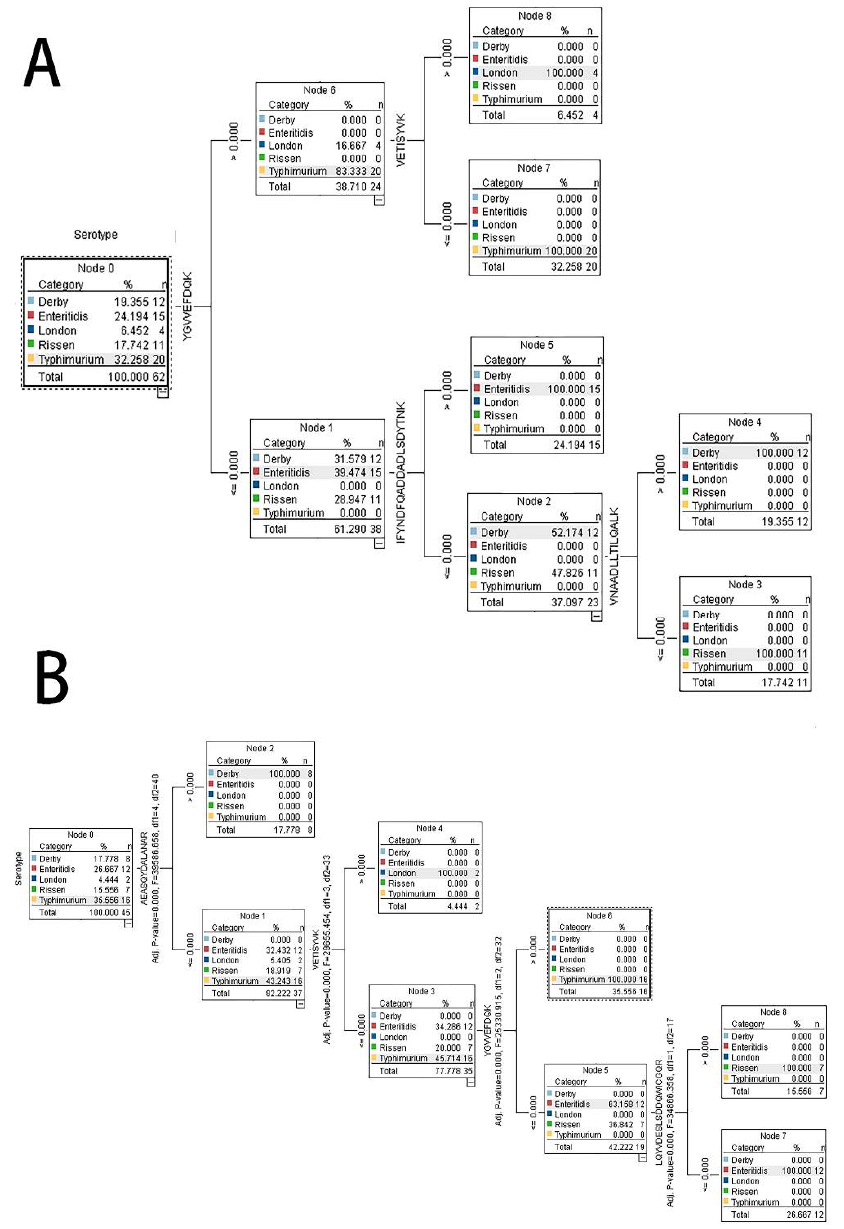
Figure 3. The decision tree for the prediction of Salmonella enteric serotypes. The model based on the C5.0 ( A ) and QUEST ( B ) method. C5.0 ( A ) and QUEST ( B )